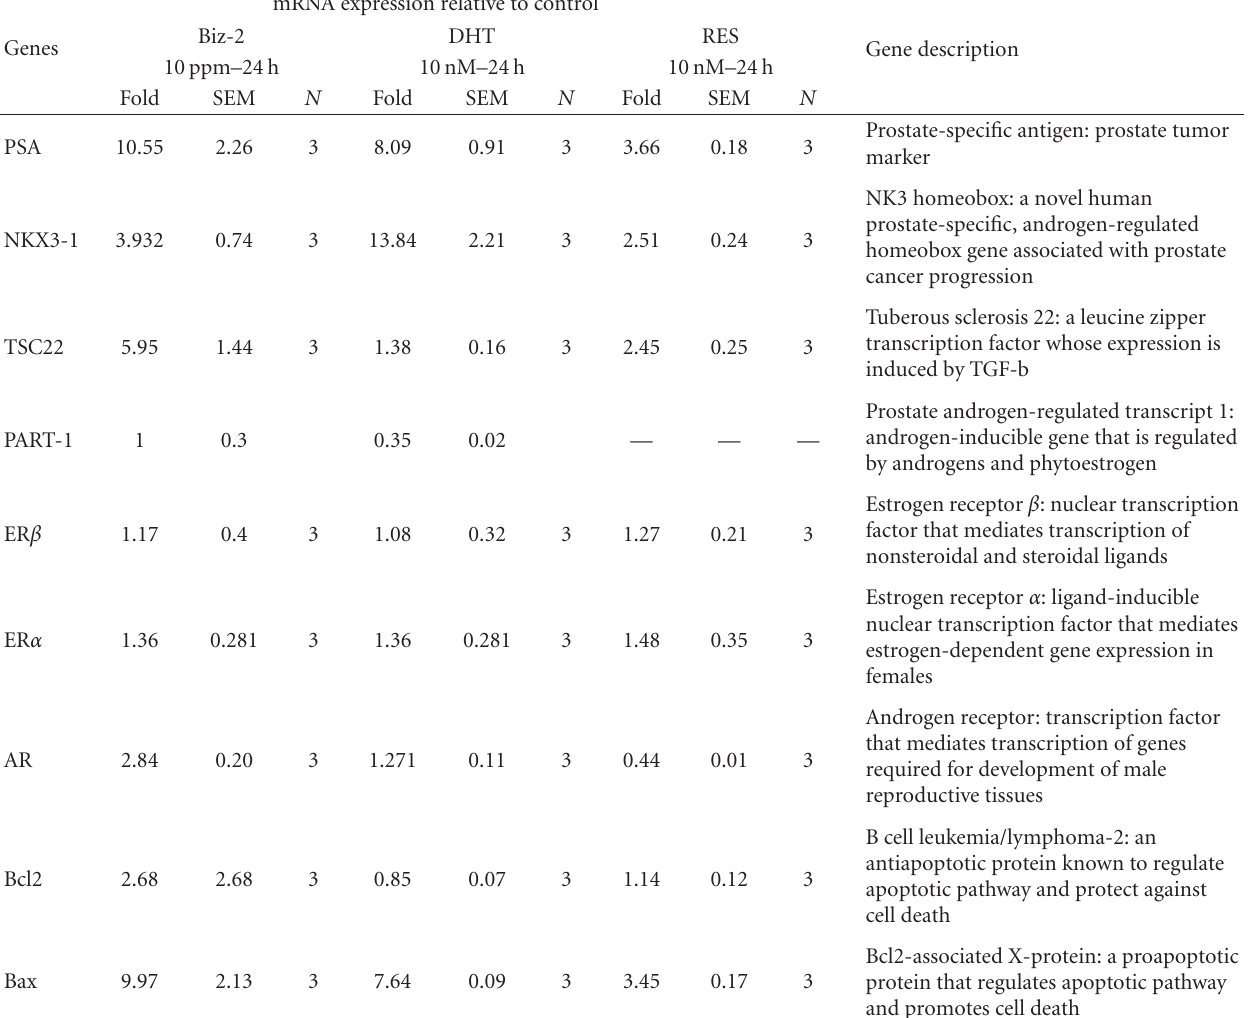
Table 1: Regulation of androgen receptor target genes by